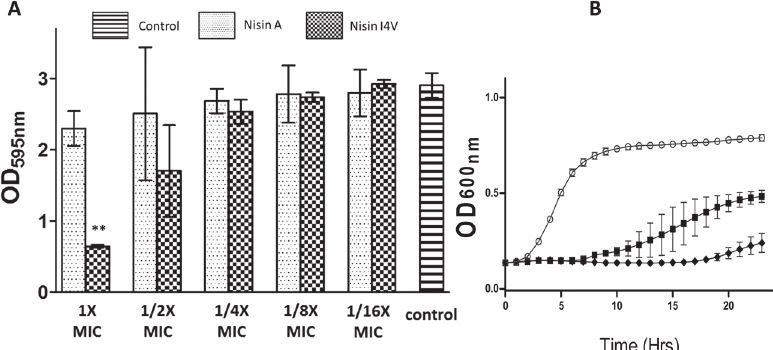
Fig 3. Inhibition of biofilm formation with nisin A and nisin I4V peptides. (A) Results of treatment of S. pseudintermedius DK729 with 1, 1/2, 1/4, 1/8 and 1/16X MIC of nisin A and nisin I4V peptides for 24 hrs prior to biofilm formation. The amount of biofilm was quantified by measuring the OD 595 of crystal violet dissolved in acetic acid. The means and standard deviations of triplicate determinations are presented. Asterisks indicate statistically significant differences (Student ’ s t-test) between peptides used at similar concentration ( ** = p < 0.01) and (B) Growth curve analysis of strain S. pseudintermedius DK729 in 1X MIC peptides of nisin A (closed square), I4V (closed diamond) and no peptide (open